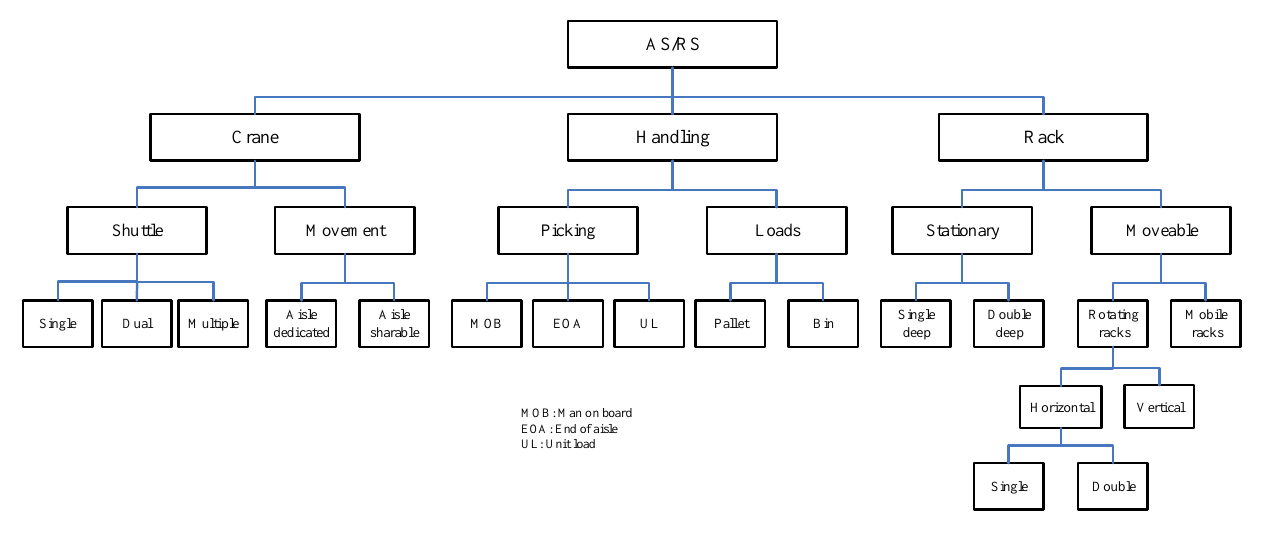
Figure 2. A classification scheme of AS/RSs.